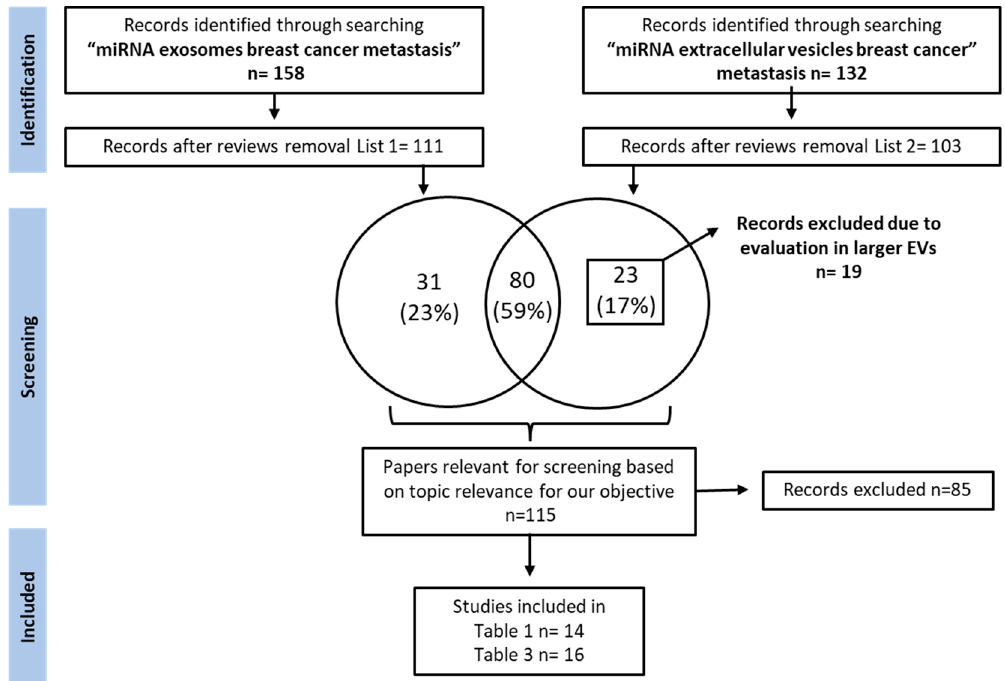
Figure 1. Study selection flow chart depicting the search strategy used for selecting papers rele- vant for this review. A thorough research of PubMed literature was performed. Reviews were excluded from the retrieved results and papers were screened for relevant articles investigating the role of exosomal miRNAs as breast cancer metastasis biomarkers. MiRNAs of interest were grouped by their level of relevance to the clinic into two tables: one containing miRNAs with im- mediate applicability as liquid biopsy biomarkers (Table 1) and another one containing miRNAs validated in preclinical studies, with potential application to the clinical setting (Table 3).